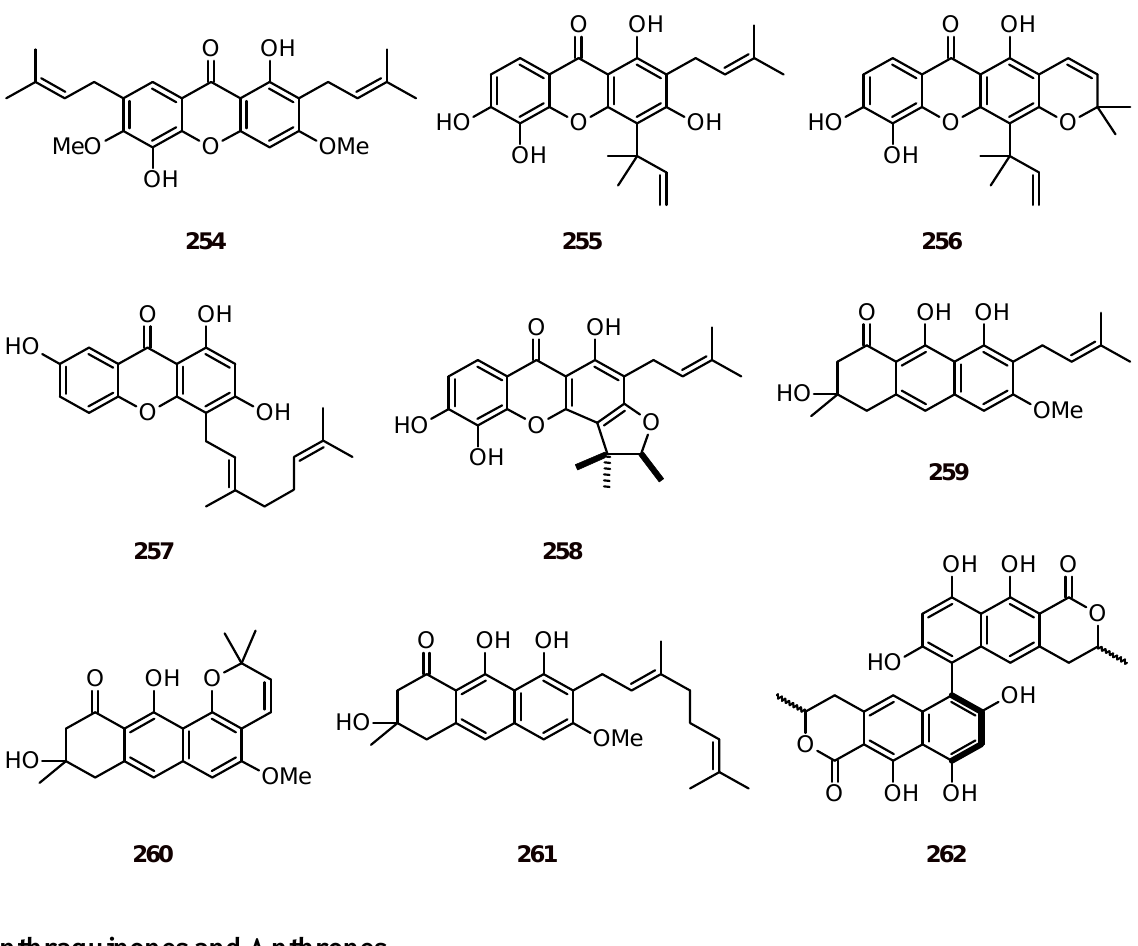
Figure 31. Structures of xanthones, naphthopyrones, and analogues vismiones 254 - 262